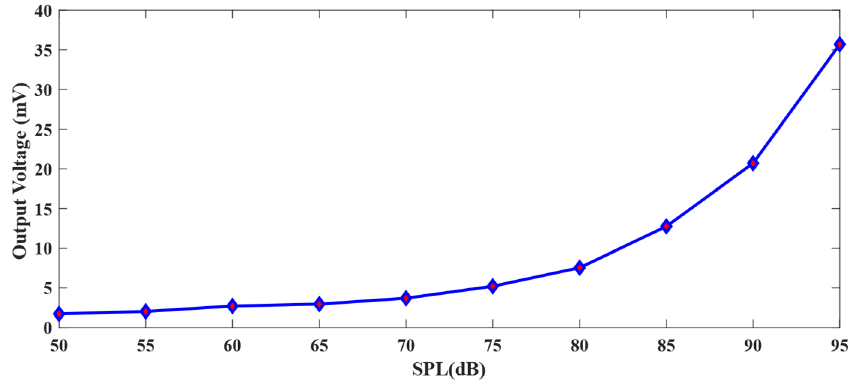
Figure 10. The response curve of SPL and output voltage.